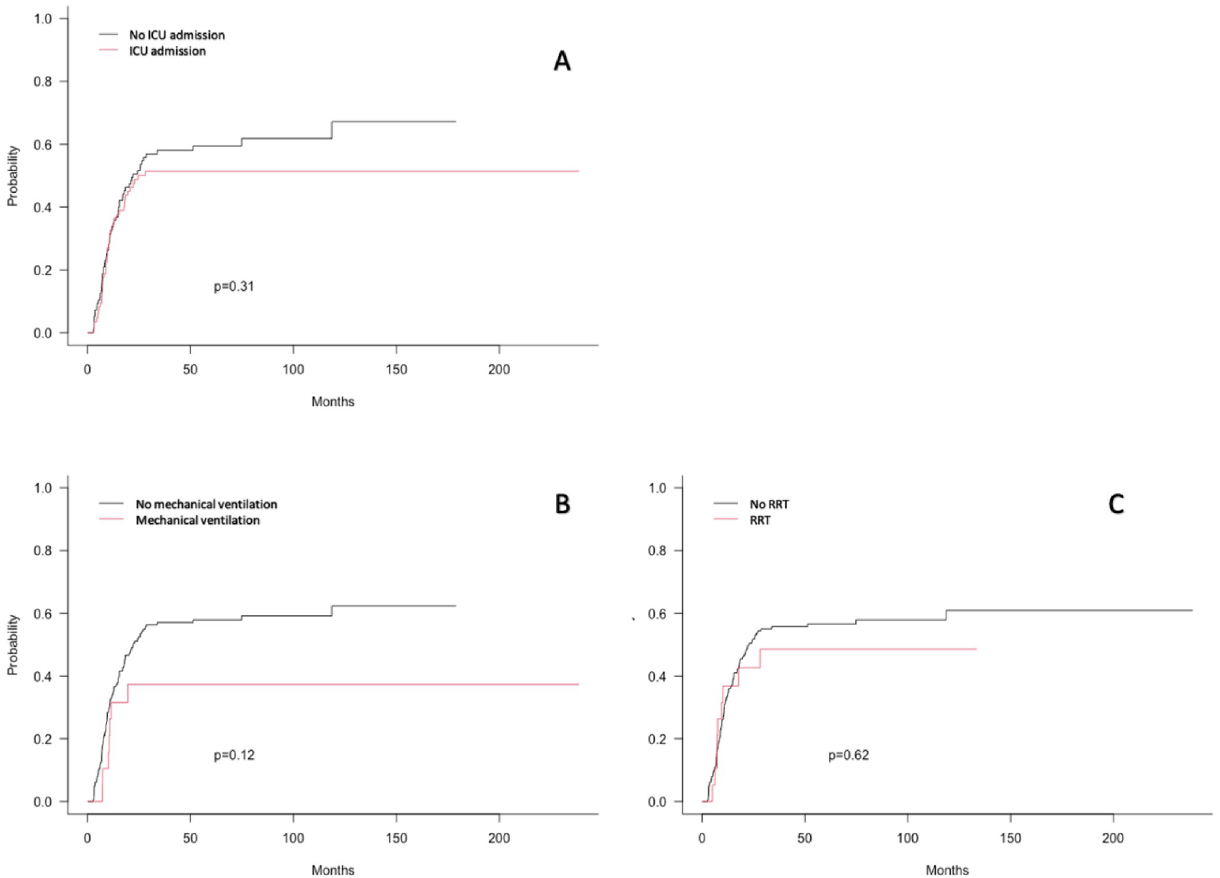
Fig 2. Cumulative incidence of relapse. (A): According to ICU admission status; (B): According to mechanical ventilation status; (C): According to renal replacement therapy status.